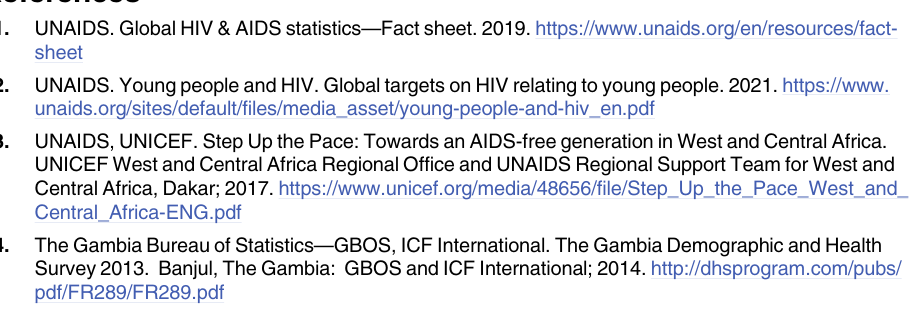
S1 Fig. The behavioral model of HIV testing services among youth 15~24 years.